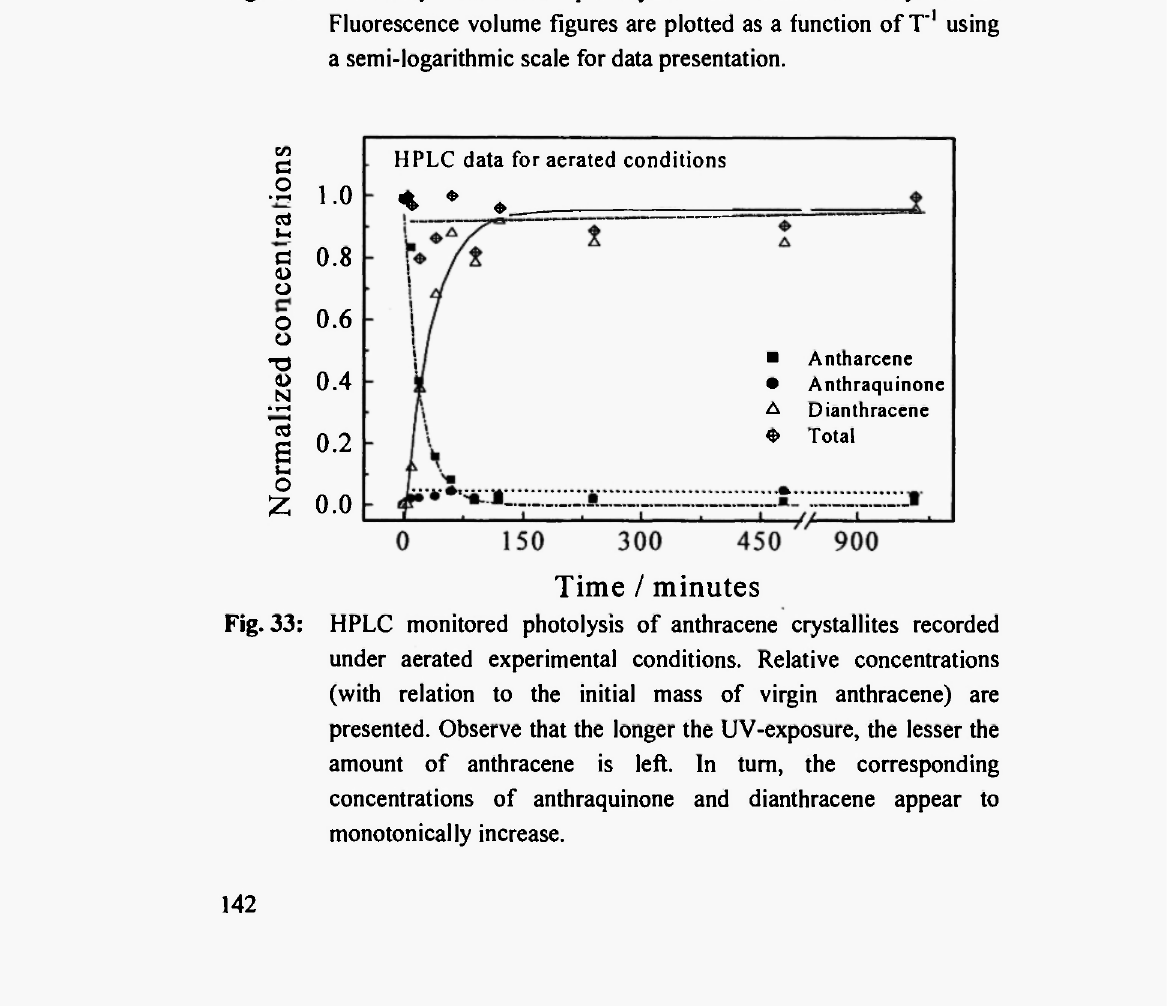
Thermally activated photolysis of anthracene crystallites. Fluorescence volume figures are plotted as a function of T" 1 using a semi-logarithmic scale for data presentation.